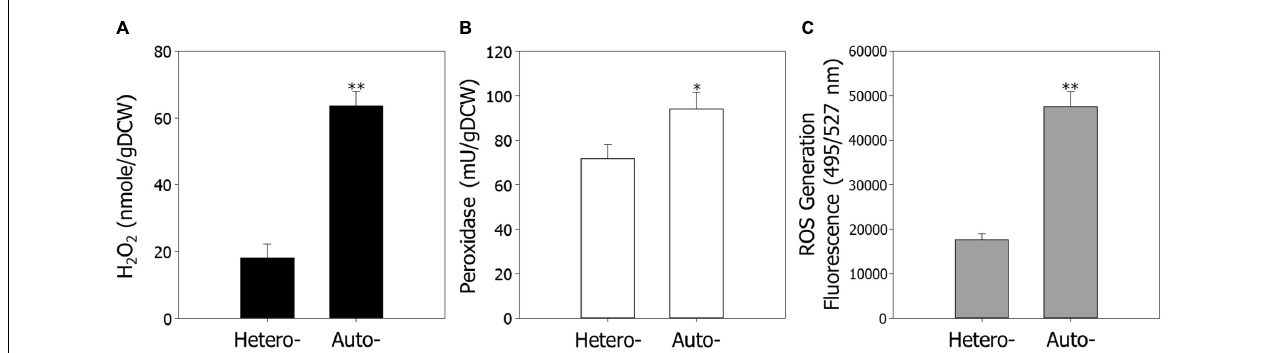
FIGURE 2 | The endogenous levels of ROS under hetero- and autotrophic conditions in Rhodobacter sphaeroides . (A) Measurement of endogenous hydrogen peroxide. (B) The activity of endogenous peroxidase. (C) Generation of ROS in cells. ROS were detected using the fluorescence dye CM-H 2 DCFDA and represented in arbitrary units. The fluorescence intensity was normalized to the optical densities of the samples. Experiments were conducted in triplicate and error bars indicate standard deviation of mean. Asterisk represents statistically significant difference, as determined by a Student t -test ( ∗ P < 0.05 and ∗∗ P <